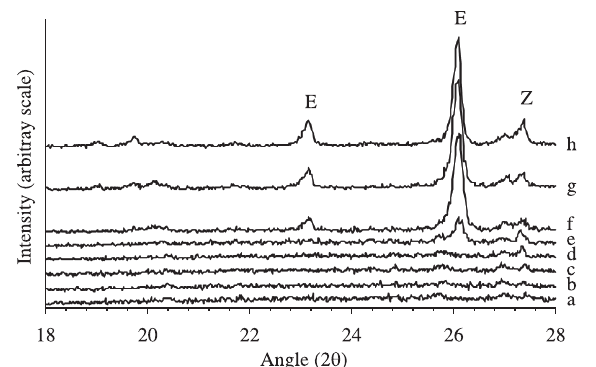
Figure 5. X ray diffraction patterns for the investigated composition heat treated at several temperatures: (a) room temperature; (b) 700 °C;